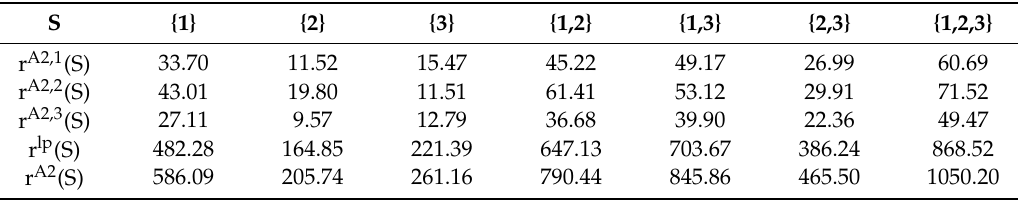
Table 15. Aggregated labor and production cost game r lp